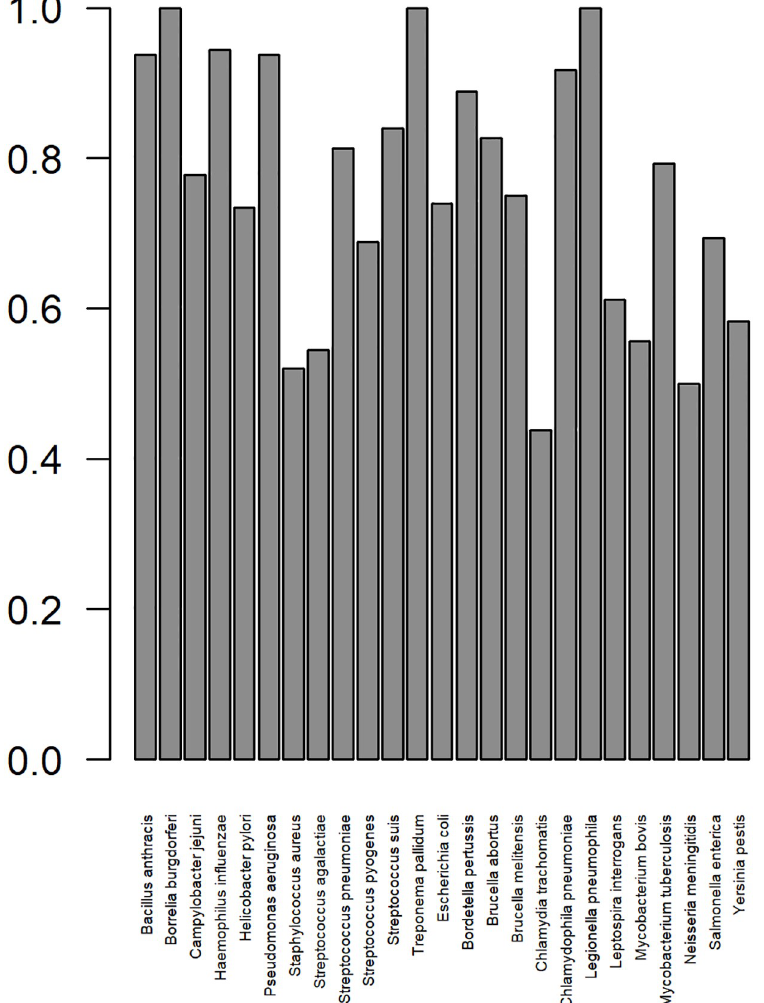
Fig 6. Area under the curve when predicting bacterial protective antigens (BPAs) and non-BPAs for each bacterial species that was left out of the training data and used as a test set, leave one bacteria out validation (LOBOV). All bacterial species in the dataset BPAD200 were left out of the training dataset to form a testing set in succession if there were > 4 examples of BPAs and non-BPAs combined in BPAD200 from that bacterial species.